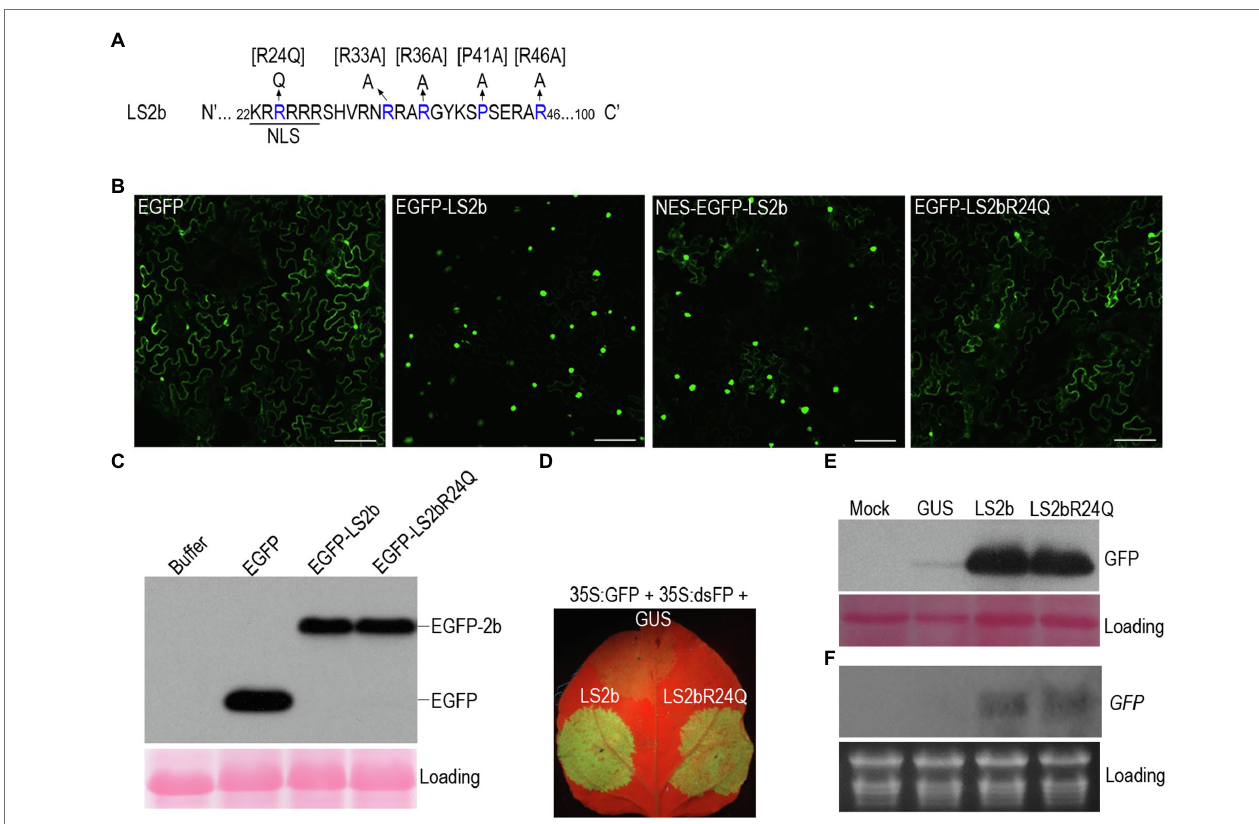
FIGURE 2 | Subcellular distribution and suppressor activity of LS2b and its variants. (A) Partial sequence of the LS2b protein showing the nuclear localization signal and its mutant R24Q. Additional mutants bracketed were determined for their suppressor activity as shown in Figure 6 . (B) GFP fluorescent in the epidemic cells of N. benthamiana plants transiently expressing free enhanced GFP (EGFP), or EGFP fusion proteins of LS2b and its mutant R24Q, namely EGFP-LS2b or EGFP-LS2bR24Q, respectively. NES-EGFP-LS2b is the variant of EGFP-LS2b that contains a nuclear exportation signal at its N terminus. GFP fluorescence was visualized at 3 days post-infiltration (dpi) by confocal scanning laser microscopy. Bars show 2 μ m. (C) Immunoblot analysis of the stability of EGFP-LS2b and EGFP- LS2bR24Q using a polyclonal serum against GFP. The protein samples were prepared from the leaf tissues at 3 dpi. Ponceau S staining was used to show equal amount of total proteins loaded. (D–F) Comparison of suppressor activity of LS2b and LS2bR24Q in agroinfiltration assays. The 6th true leaves of N. benthamiana plants were infiltrated with agrobacterium cells to express GFP reporter (35S:GFP) and an inverted repeat RNA of GFP (35S:dsFP) as a silencing inducer, together with GUS, LS2b or LS2bR24Q as indicated. (D) GFP fluorescence produced from the agroinfiltrated leaves were photographed under UV light at 5 dpi. (E) Immunoblot analysis of GFP protein accumulation. A polyclonal anti-GFP serum was used to probe GFP protein. Ponceau S staining was used to monitor the relative amount of total proteins loaded. (F) RNA gel blot analysis of steady-state accumulation of GFP transcripts. GFP transcripts were detected using the DIG- labeled DNA probe that was made using the DIG high primer DNA labeling and detection starter kit II. Ribosomal RNAs stained by ethidium bromide were used as a loading